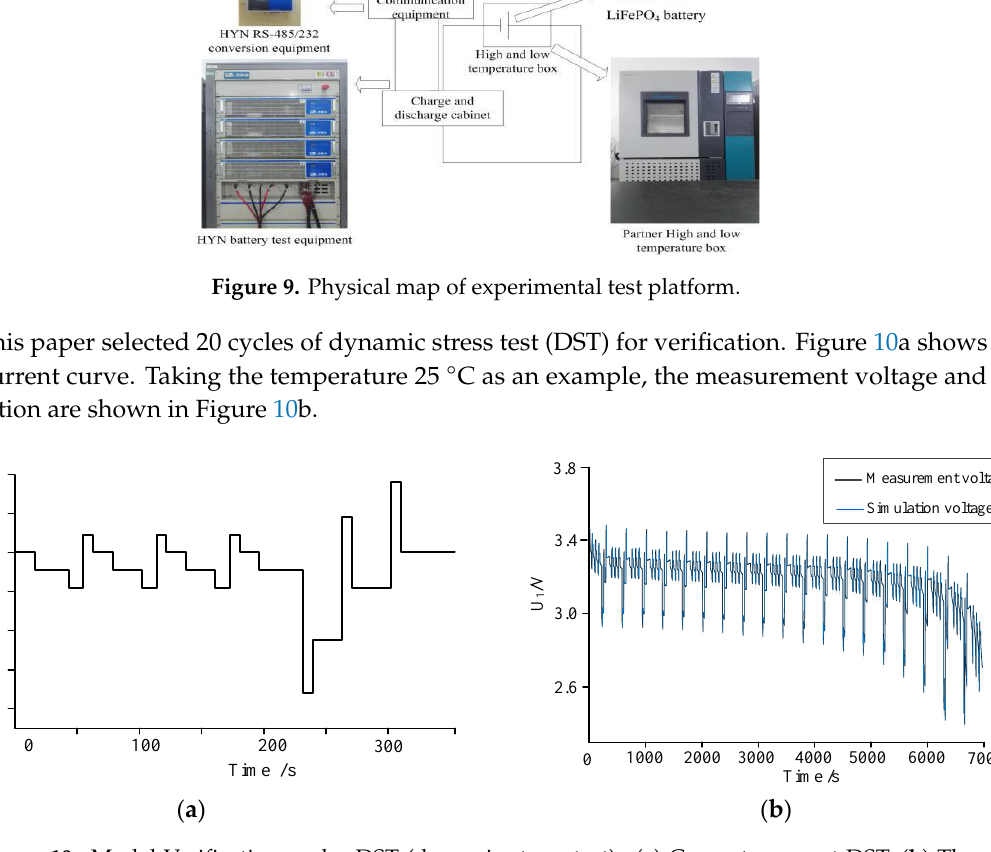
Figure 10. Model Verification under DST (dynamic stress test). ( a ) Current curve at DST. ( b ) The measurement voltage and simulation voltage.